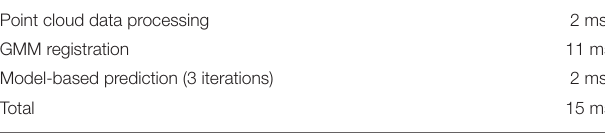
TABLE 3 | Time consumptions of the state